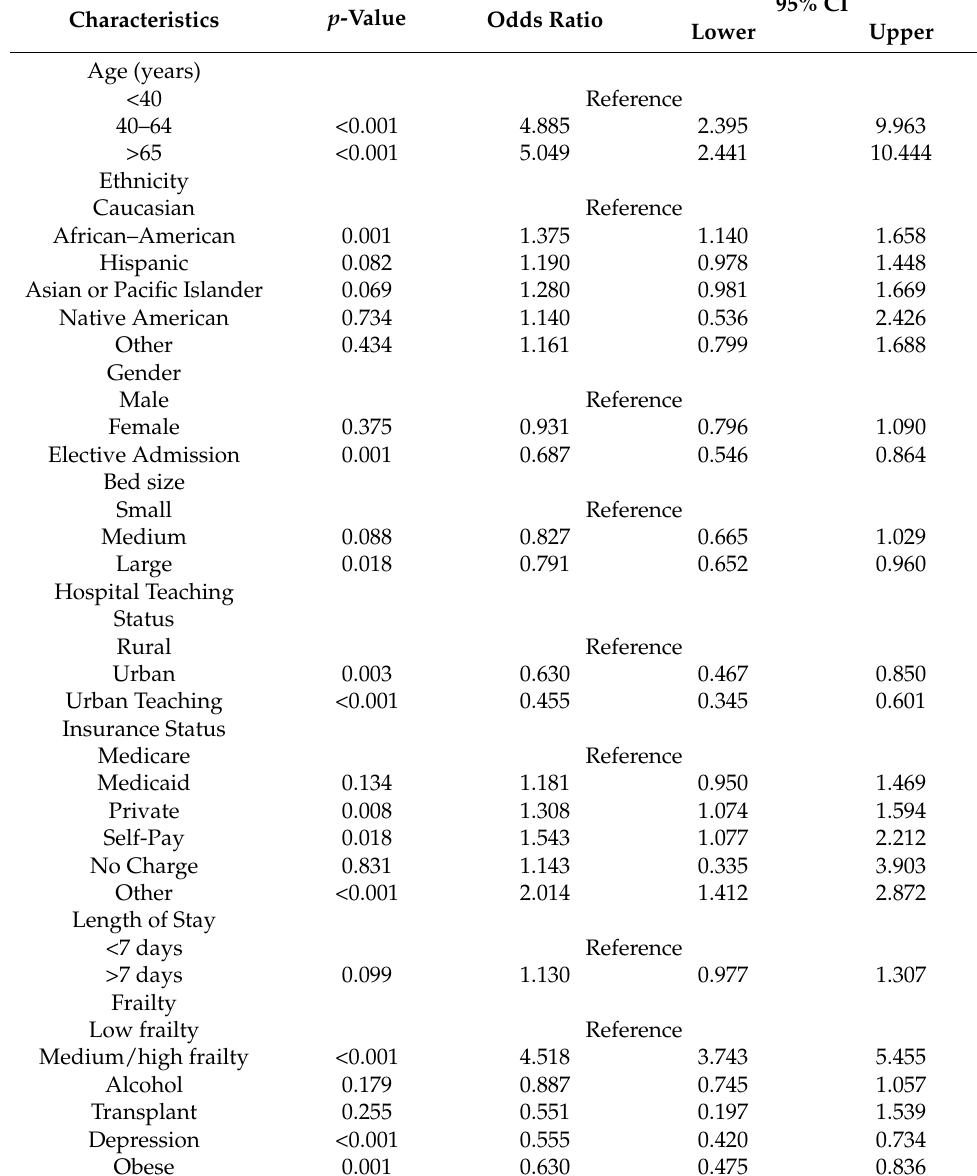
Table 2. Logistic regression model showing the effect of frailty on patient mortality.